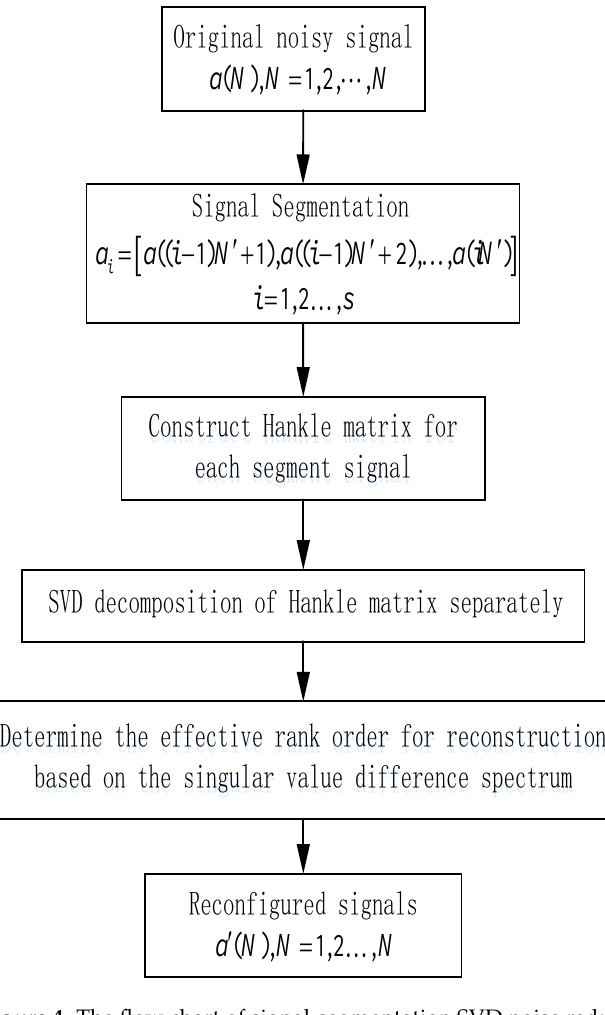
Figure 4. The flow chart of signal-segmentation SVD noise reduction.